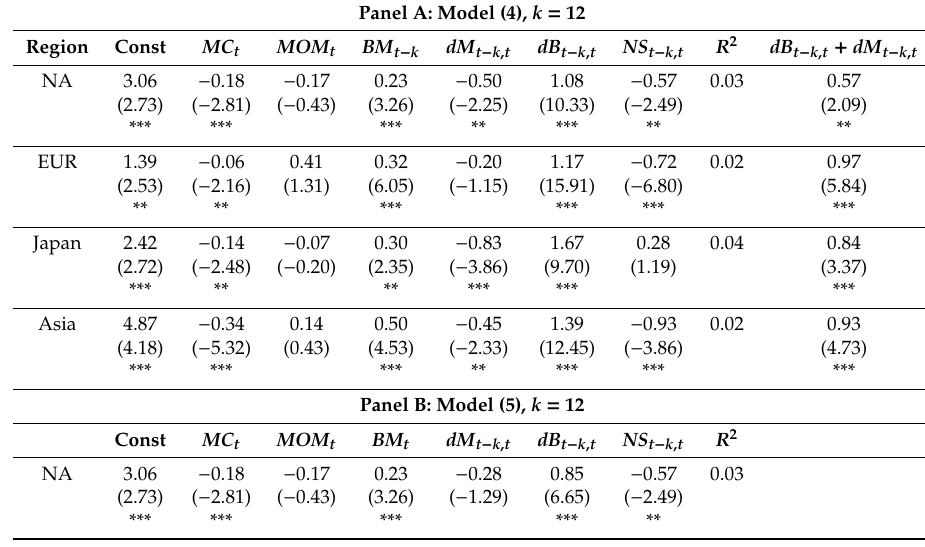
Table 7. Models (4) and (5) Regression Estimates—Subperiod 2004–2016. Results presented in Panel